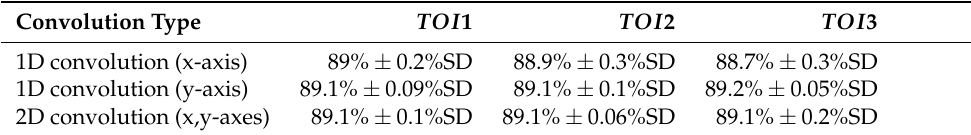
Table 5. The specificity depending on the convolution type and the EEG